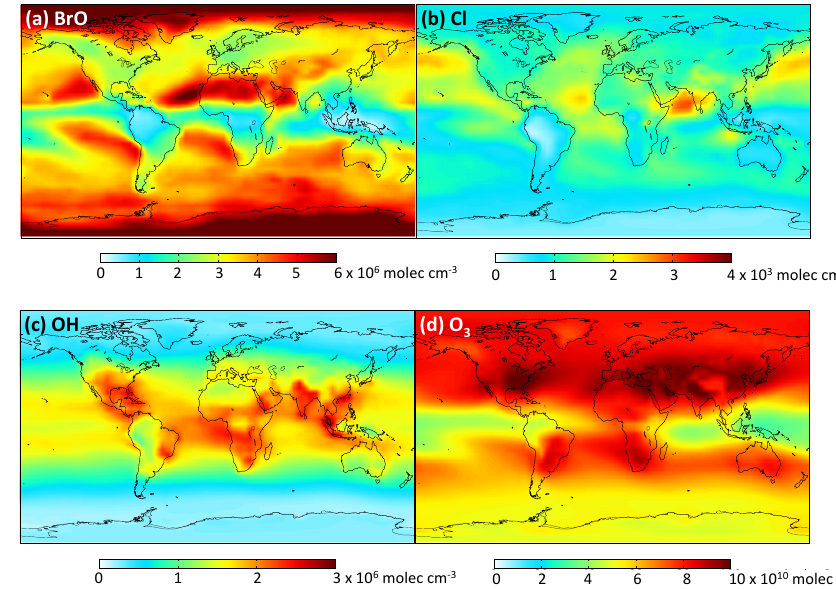
Figure 12. Global tropospheric distribution of annual-mean gas-phase (a) BrO, (b) Cl, (c) OH and (d) O 3 concentration.